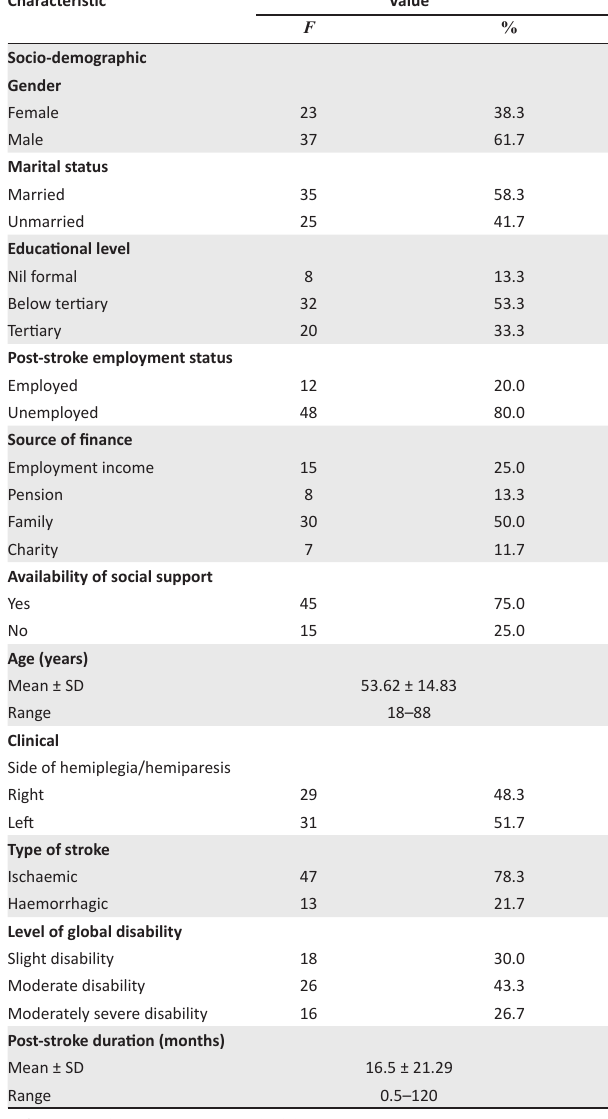
TABLE 1: Personal factors of participants ( N = 60).